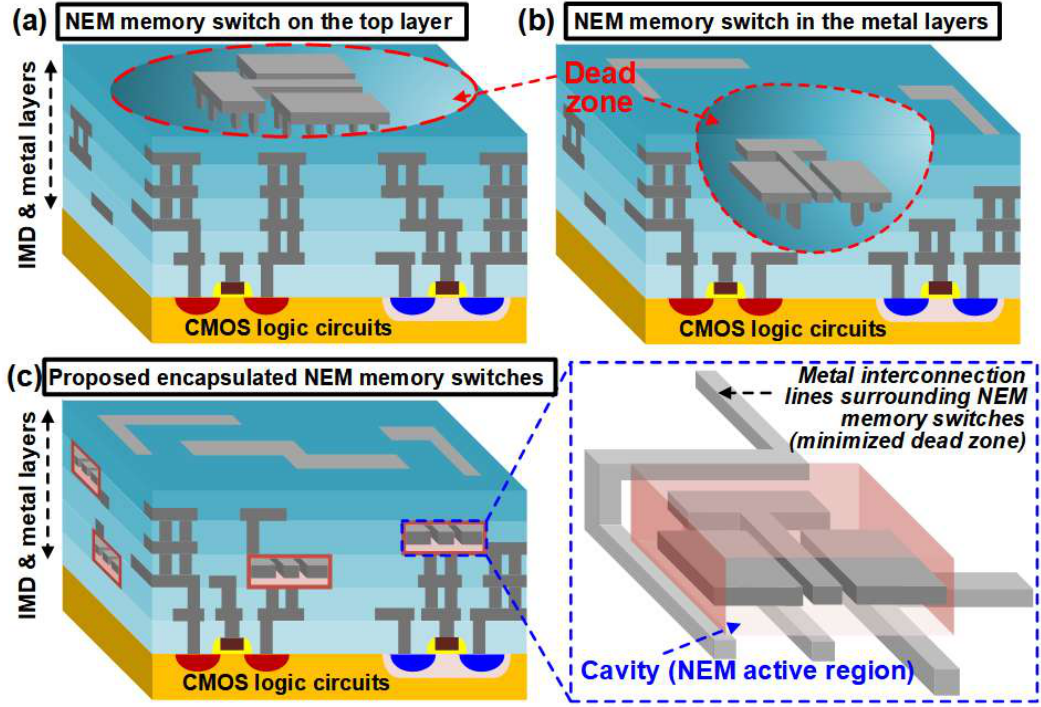
Figure 1. Conceptual views of ( a ) a nanoelectromechanical (NEM) memory switch only on the top layer, ( b ) a NEM memory switch in the CMOS back-end-of-line (BEOL) metal layers and ( c ) the